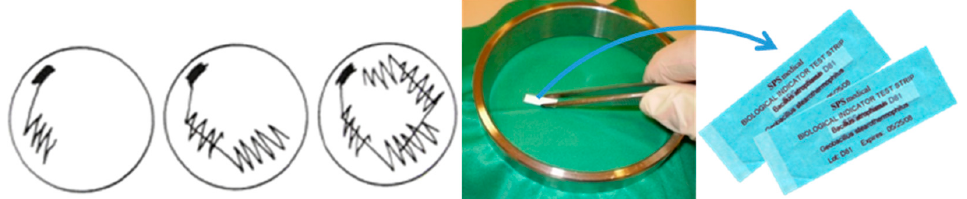
Figure 6. Illustration of the application of bacterial spores of Geobacillus Stearothermophilus and Bacillus Atrophaeus to the sample test field.